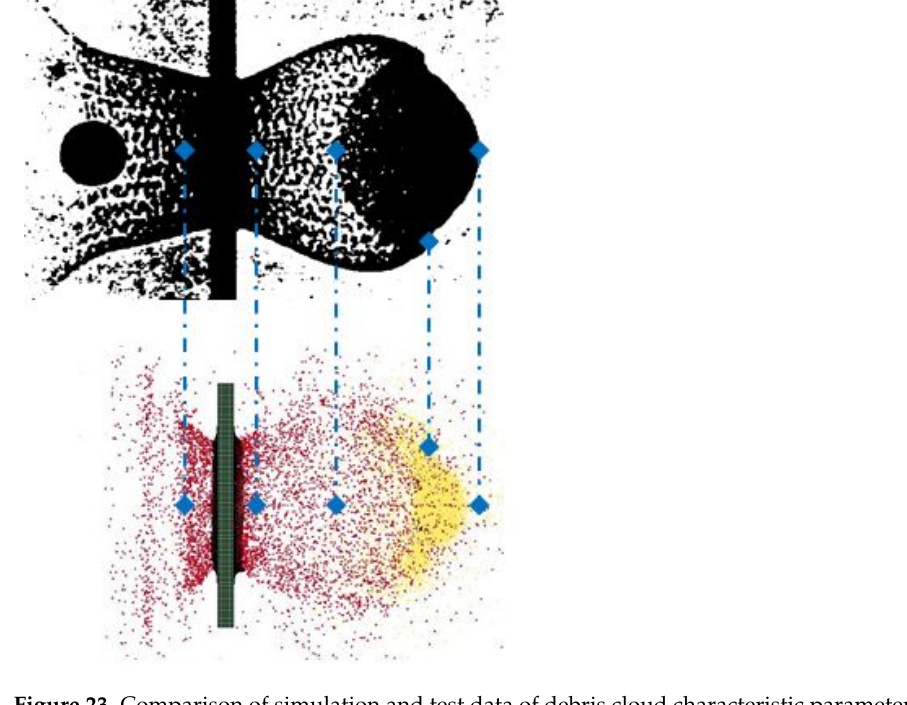
Figure 23. Comparison of simulation and test data of debris cloud characteristic parameters.